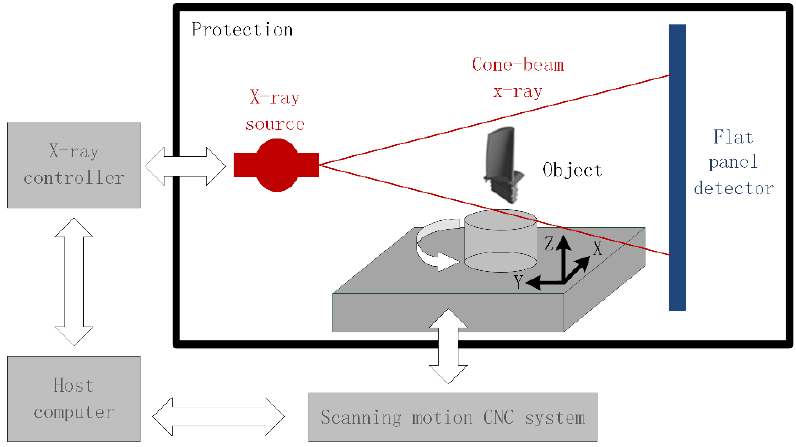
Figure 2. The working principle of the ICT system.